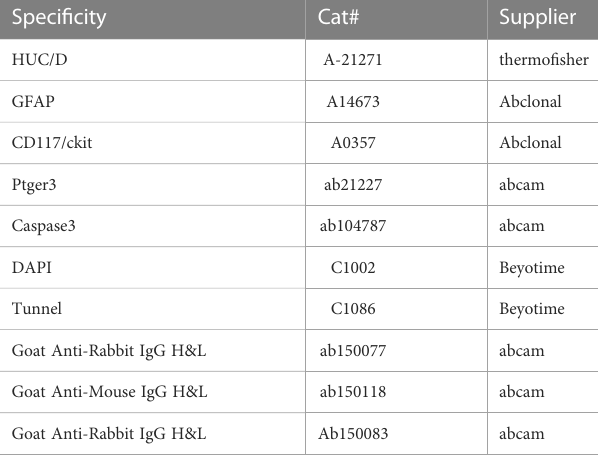
TABLE 3 Sources of commercial antibodies used in immuno fl uorescence experiments.